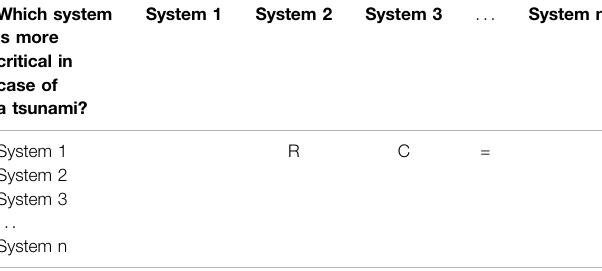
TABLE 1 | Fac-simile of the paired comparison questionnaire. Which system is